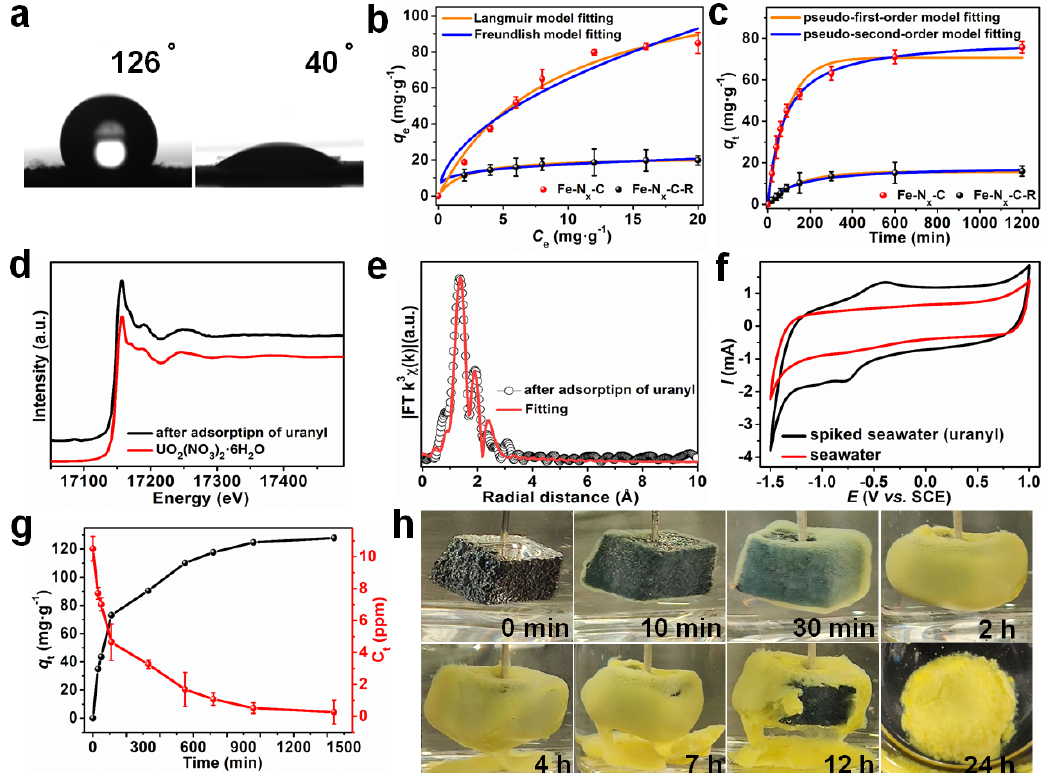
Figure 2. ( a ) Contact angles for deionized water on pressed pellets of nitrogen-doped carbon capsules supporting iron single-atom sites (Fe − N x − C) (left) and polypropylene amidoxime coated Fe ‒ N x − C (Fe − N x − C − R) (right). ( b ) Equilibrium adsorption isotherms for uranyl ion adsorption on different materials at a fixed material ‒ to ‒ solution ratio of 0.1 mg·mL − 1 in uranyl ‒ spiked seawater (from 0 to 20 ppm). ( c ) Uranyl ion adsorption kinetics on different materials at an initial UO 22+ concentration of 10 ppm in uranyl ‒ spiked seawater. ( d ) U L III ‒ edge XANES spectra for Fe − N x − C − R after adsorption of uranyl, and UO 2 (NO 3 ) 2 ·6H 2 O. ( e ) U L III ‒ edge EXAFS R-space and corresponding fitting curves for Fe − N x − C − R after adsorption of uranyl. ( f ) Cyclic voltammograms for uranyl-spiked seawater and natural seawater. ( g ) Uranium extraction from spiked seawater with initial uranium concentrations of ~10 ppm, using Fe − N x − C − R as an adsorbent electrocatalyst. ( h ) Photographs of the Fe − N x − C − R electrode in spiked seawater (initial uranium concentration of ~1000 ppm) during electrocatalytic extraction Reprinted with permission from ref. [22]. Copyright 2021 John Wiley and Sons.